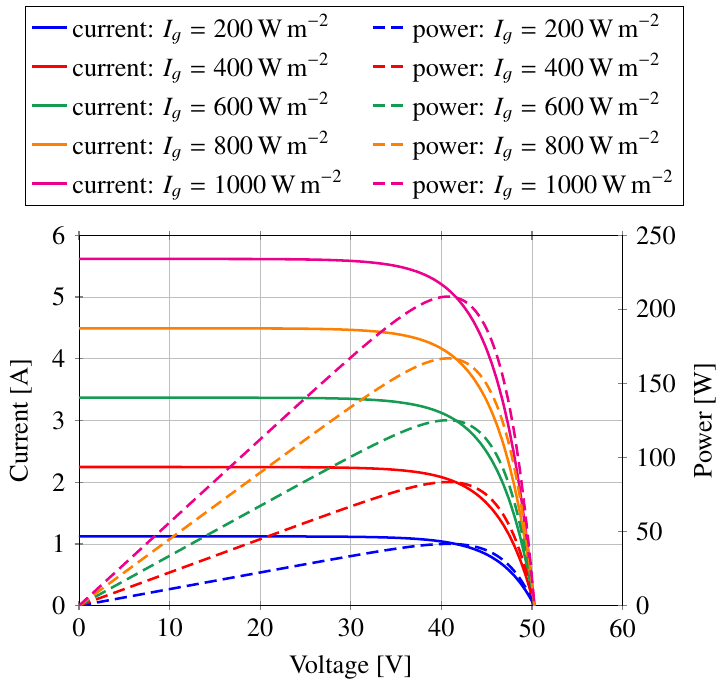
Figure 3. I - V (solid lines) and P - V (dashed lines) characteristics of the considered photovoltaic (PV) panel for various solar irradiations and for a cell temperature of 30 ◦ C.